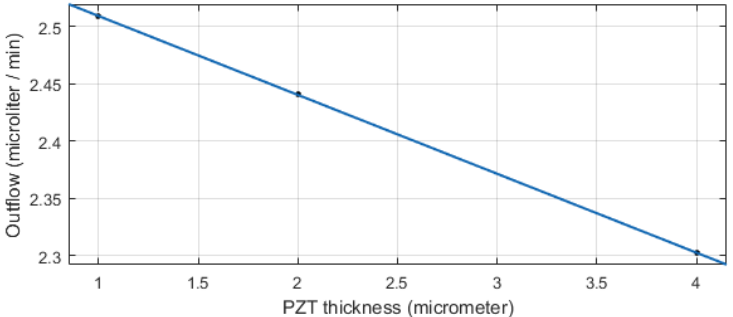
Figure 14. The outflow dependance of the device on the thickness of the lead zirconate titanate (PZT)